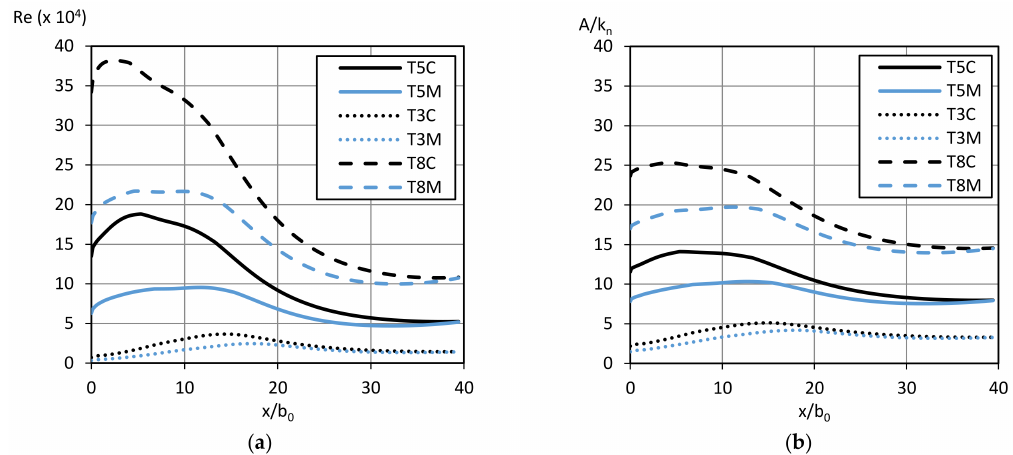
Figure 11. Simulations of wave-current interaction for different peak periods (3 s, 5 s and 8 s) and assuming Collins and Madsen approaches: ( a ) Reynolds numbers and ( b ) relative roughness A /k n , along the centerline of the jet current.